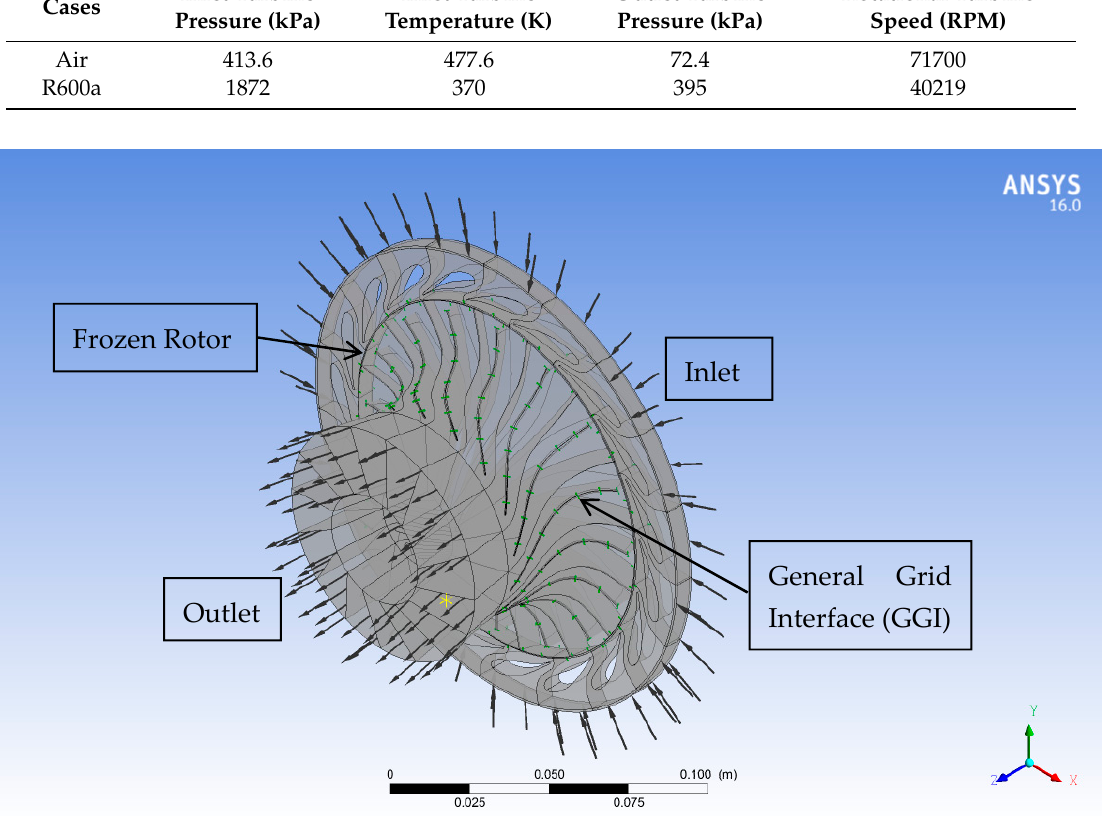
Figure 5. Boundary conditions for the full turbine model including the entire rotor and stator blades.